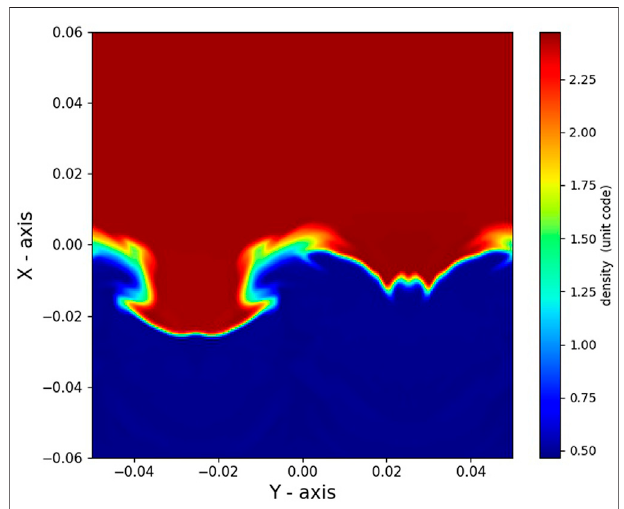
FIGURE 8 | The plot shows the simulation result for the different driver taking the relevant theoretical eigenfunction of the surface Alfvén wave. The snapshot is taken at z (cid:1) 0.3 and t (cid:1) 3.